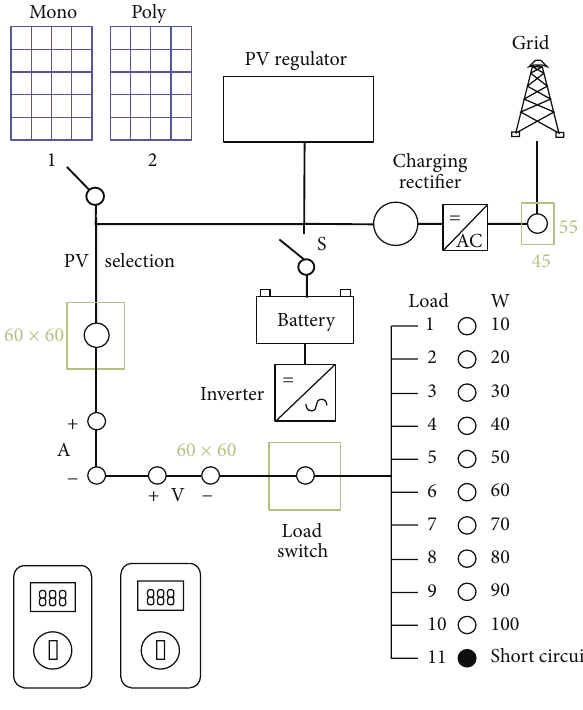
Figure 1: Schematic view.